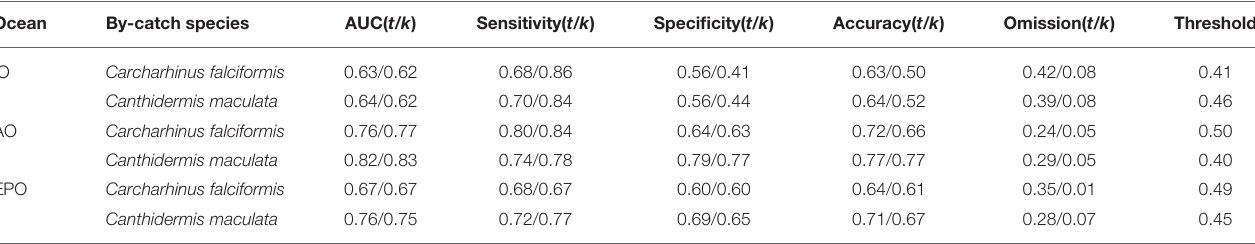
TABLE 4 | Model evaluations with all observations ( t ) and cross-validated ( k ) for Carcharhinus falciformis and Canthidermis maculata in the Indian (IO), Atlantic (AO), and Eastern Pacific Ocean (EPO). Ocean By-catch species AUC( t / k ) IO